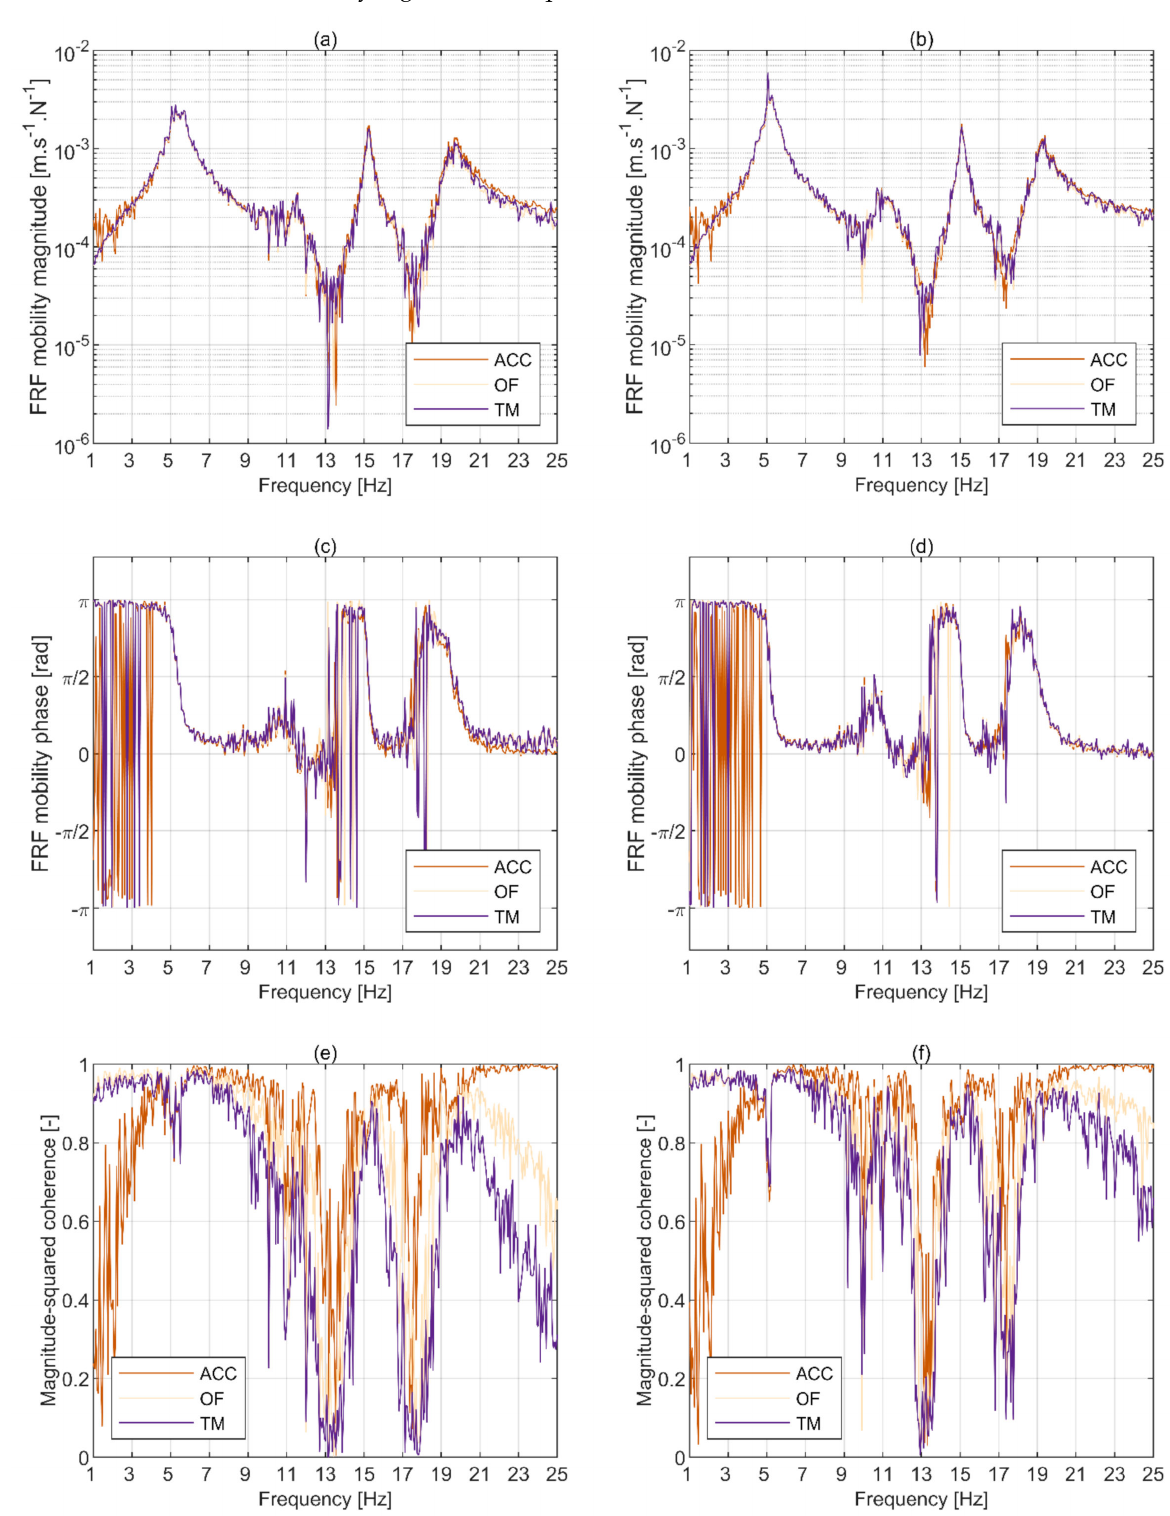
Figure 8. Driving point mobility for T1 & T2, respectively, in terms of ( a , b ) magnitude and ( c , d ) phase, together with ( e , f ) magnitude-squared coherence. All signals were processed using 71 blocks of 16 s length with uniform window and 50% overlap, giving frequency resolution ∆ f = 0.0625